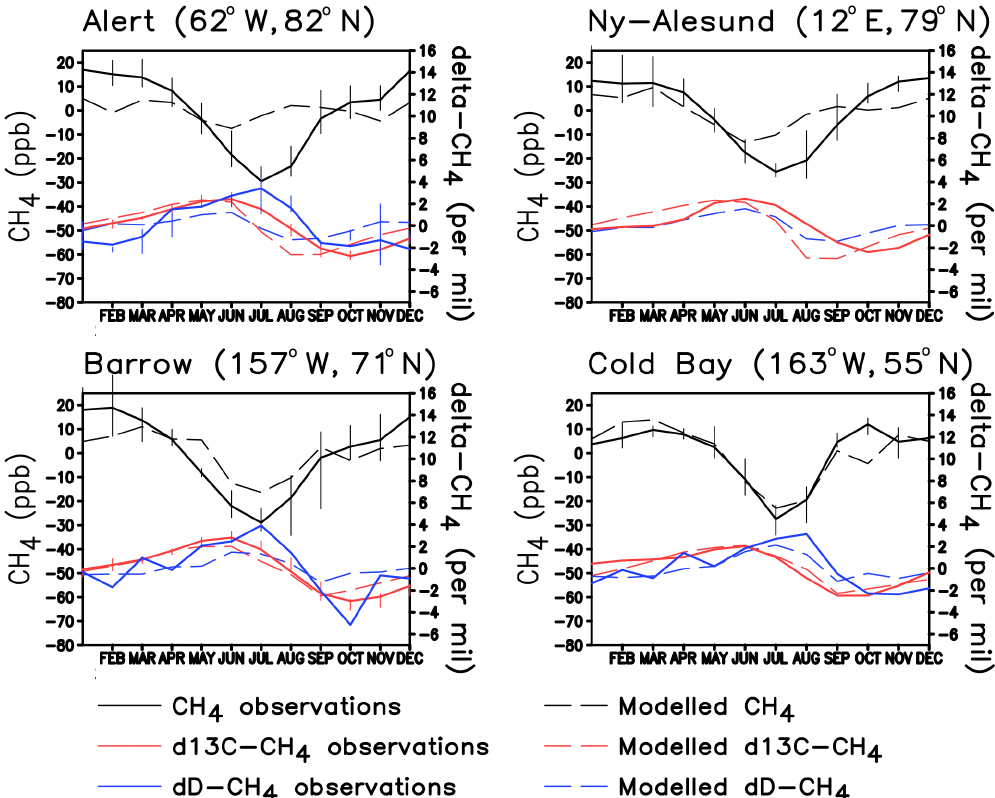
Figure 5. A comparison of modelled seasonal cycles of CH 4 , δ 13 C-CH 4 and δ D-CH 4 from the p-TOMCAT BASE scenario and NOAA- ESRL and CU-INSTAAR observations ( δ D-CH 4 is not shown for Ny-Alesund due to insufficient data). Annual means have been subtracted from both the model and measurement data. Variations in δ 13 C-CH 4 have been multiplied by a factor of 10. Where there are sufficient data available in the 2005–2009 period, the range of observed monthly mean values relative to the annual mean is represented by a vertical